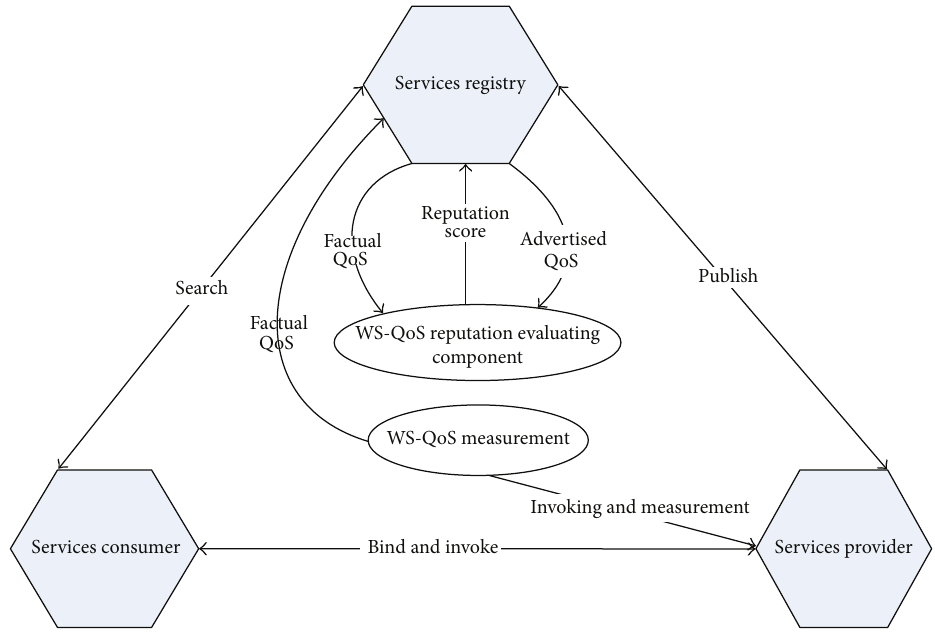
Figure 1: The Web service reputation evaluation framework.